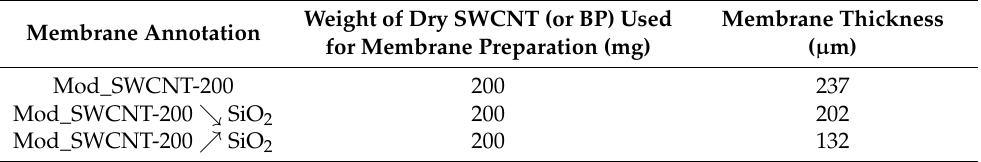
Table 4. SWCNT membranes with a hydrophobic layer.